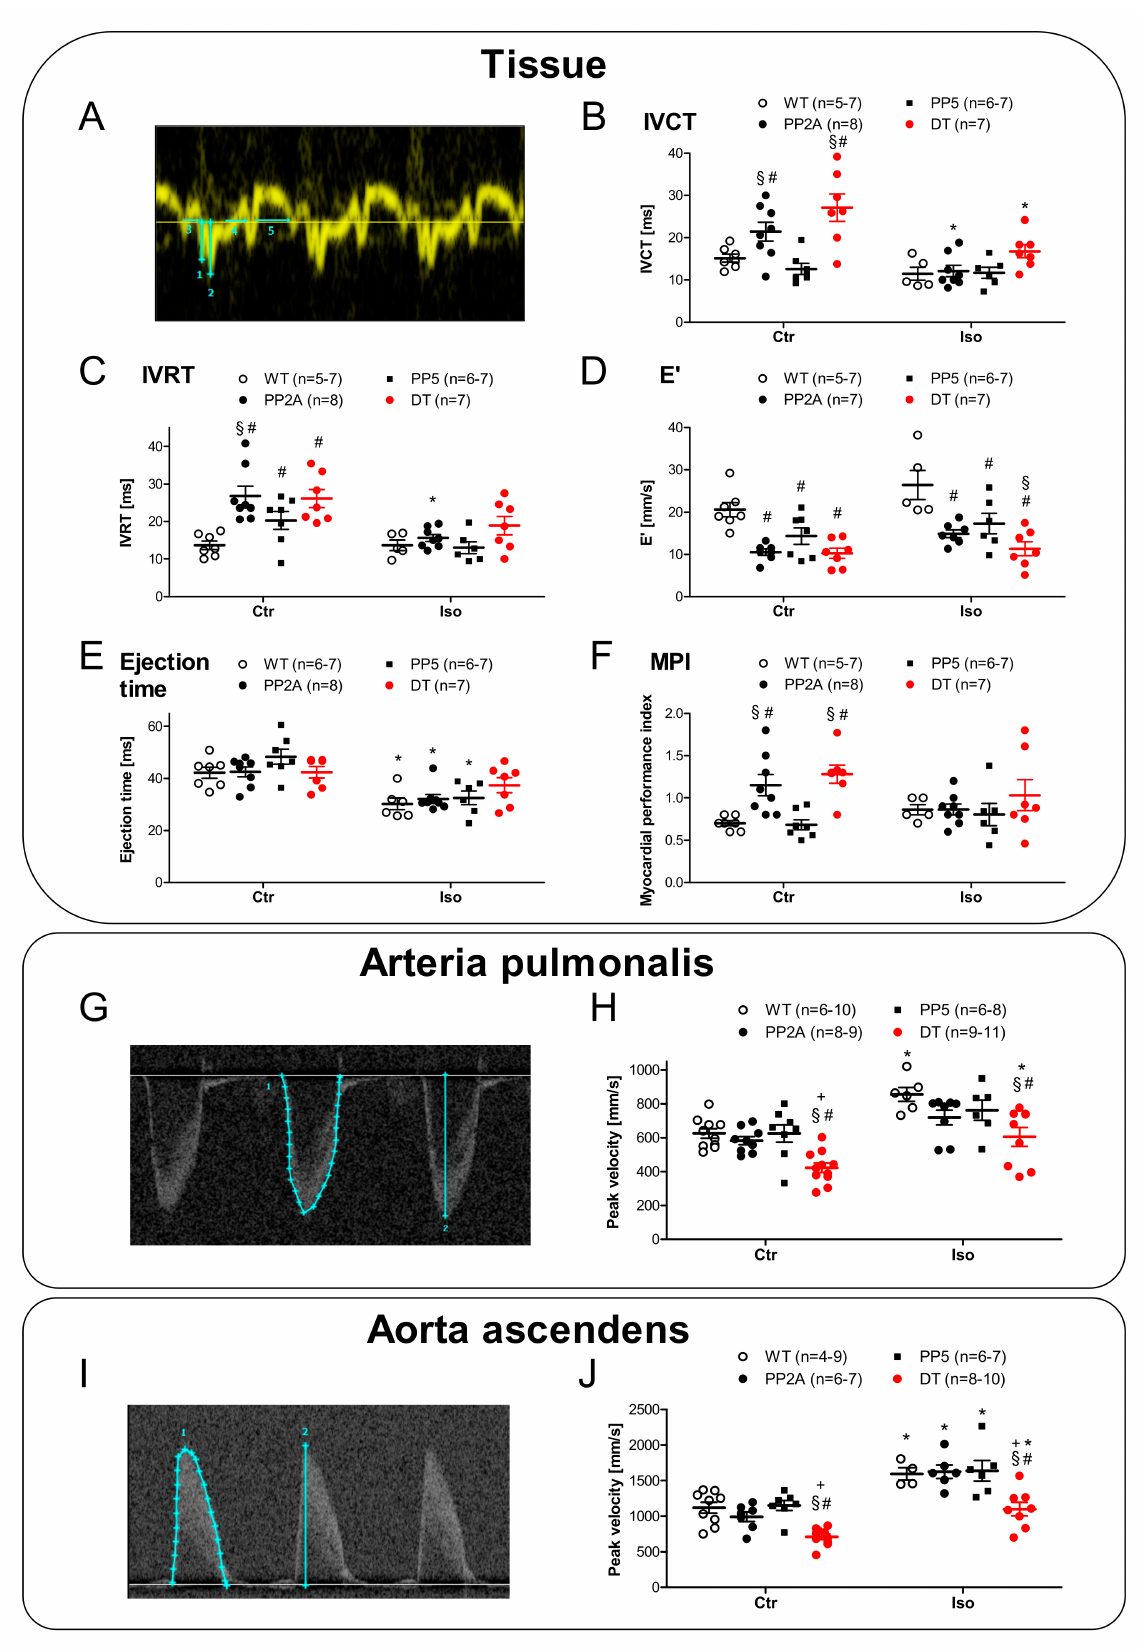
Figure 8. Typical original tracings of Doppler-echocardiography in young (age group I) mice before (Ctr) and after